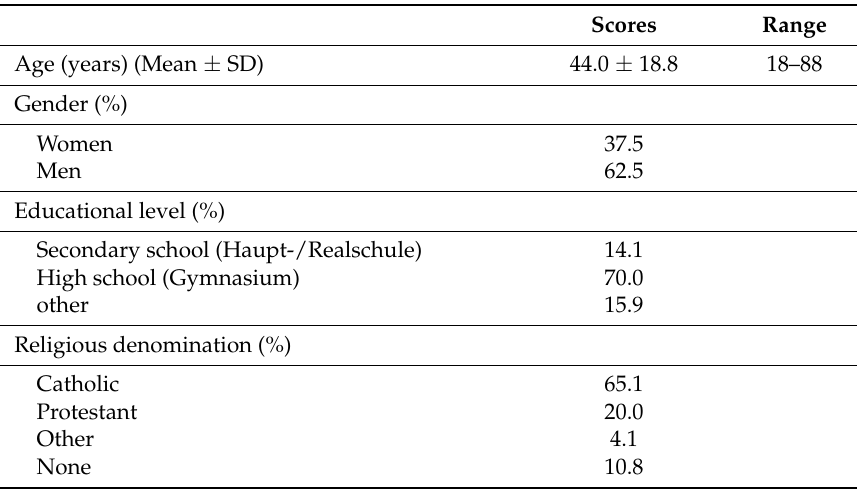
Table 2. Description of the sample (N =